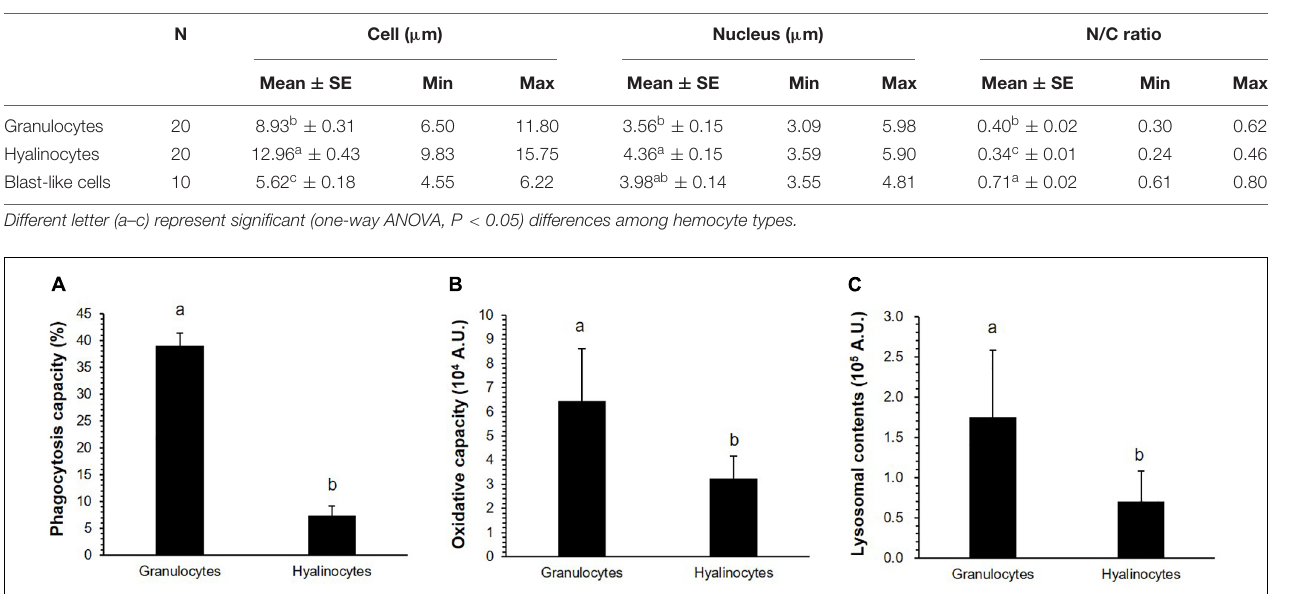
TABLE 3 | Cell and nucleus diameters and nucleus/cell (N/C) ratio.